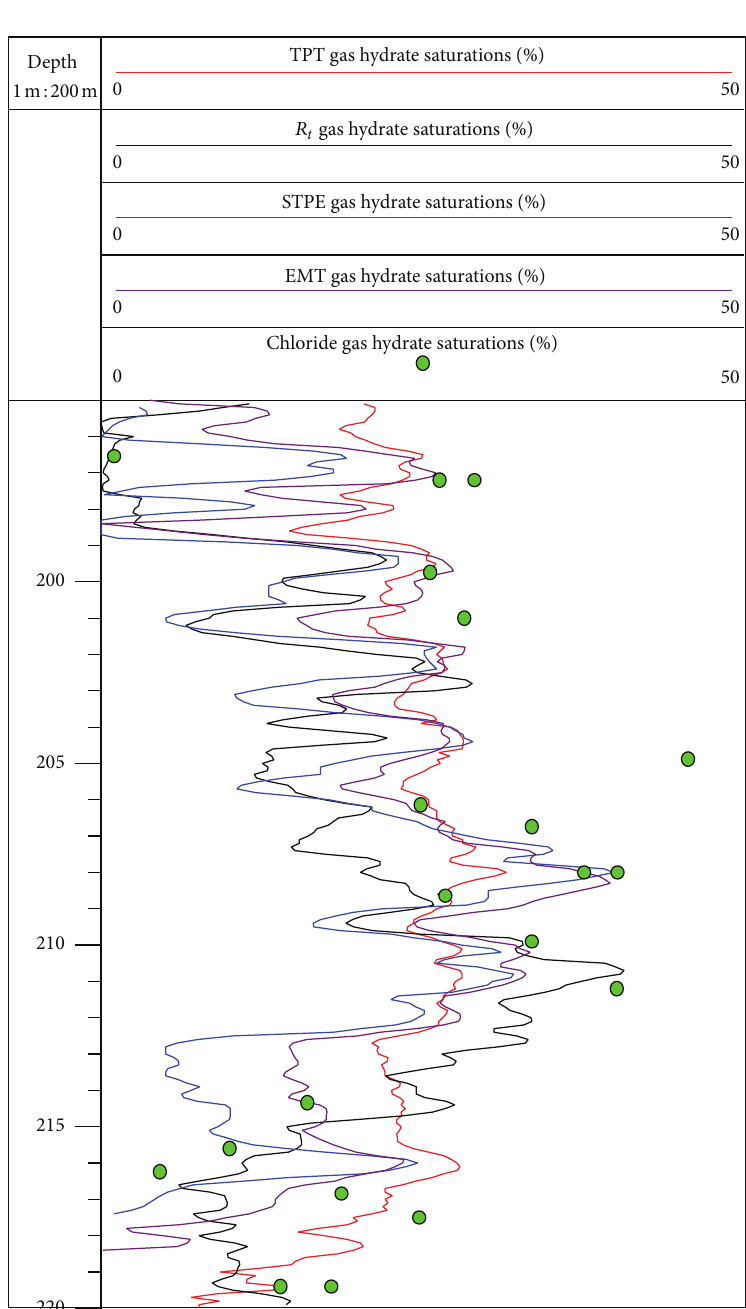
Figure 9: Comparison of estimation of gas hydrate saturation made by different methods in depth of 195 to 220 mbsf at site SH2. (The red curve, black curve, blue curve, and violet curve represent gas hydrate saturations estimated by the TPT, the Rt, the STPE, and the EMT method, respectively; the bright green dots represent gas hydrate saturations calculated by chloride anomaly